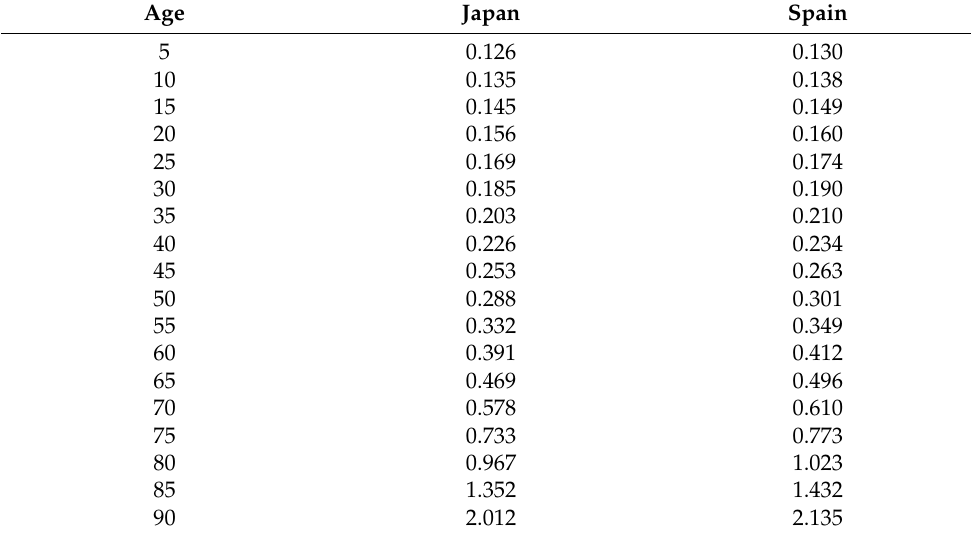
Table 1. Keyfitz entropy measurement [15] for the male population for each specific